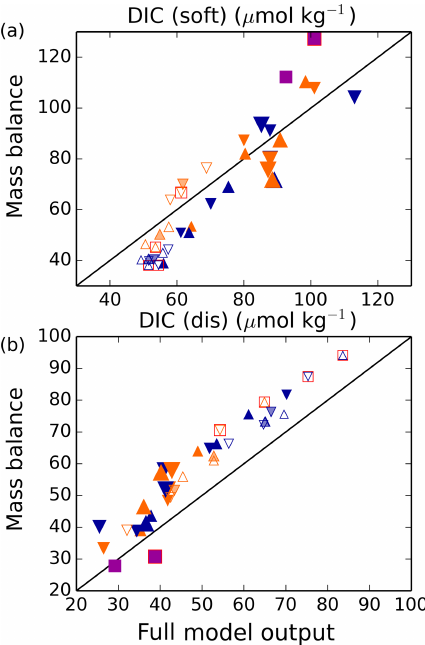
Figure 10. Simple estimation of global DIC dis and DIC soft from water mass characteristics. Following Eq. (12) for (a) DIC soft and (b) DIC dis separately, this model shows that the sum of the global average DIC soft and DIC dis at steady state can be estimated fairly robustly as the result of a simple mass balance of the relevant pa- rameters in the most important ventilating water masses. Here, we take into account upper-ocean water masses (above 1km) formed in the North Pacific, North Atlantic, and Southern Ocean, and deep water masses formed in the North Atlantic and Southern Ocean. In each plot, the full model output is shown on the x axis and the result of the mass balance approximation on the y axis. Orange and blue symbols represent high and low obliquity scenarios, respectively; triangles pointing upward and downward represent greater North- ern and Southern hemisphere seasonality (precession 270 and 90 ◦ ); outlines are scenarios with LGM ice sheets; light shading indicates scenarios with LGM ice sheet topography but PI albedo. Five sim- ulations, for which no deep convection events were identified south of 60 ◦ S, are not shown. The size of the symbols corresponds to the SAT. The purple square represents the pre-industrial simulation (run 41), and red boxes indicate Fe fertilization simulations (runs